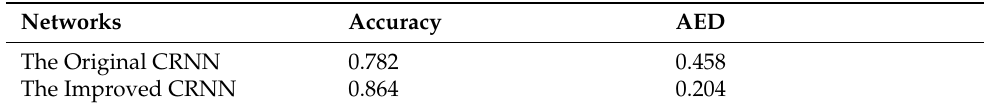
Table 3. The evaluation results in uyghur text recognition.